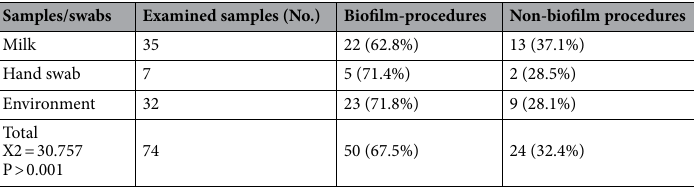
Table 3. Prevalence of the biofilm producing capacity of isolated P. aeruginosa collected from samples during the study period.